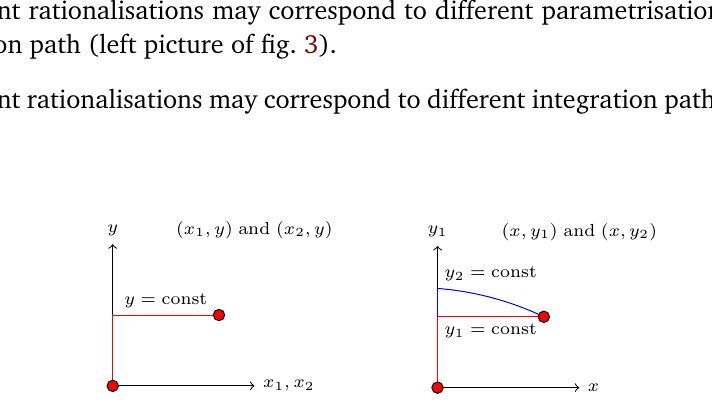
Figure 3: The left picture shows two parametrisations of the same integration path, the right picture shows two different integration